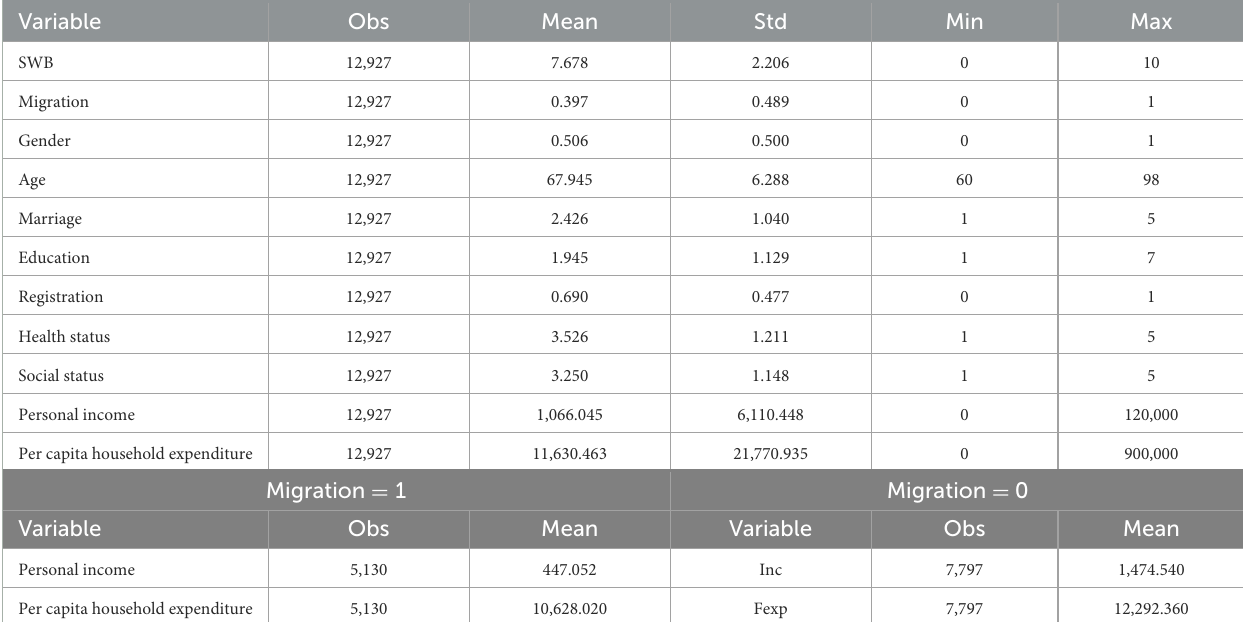
TABLE 1 Descriptive statistics of